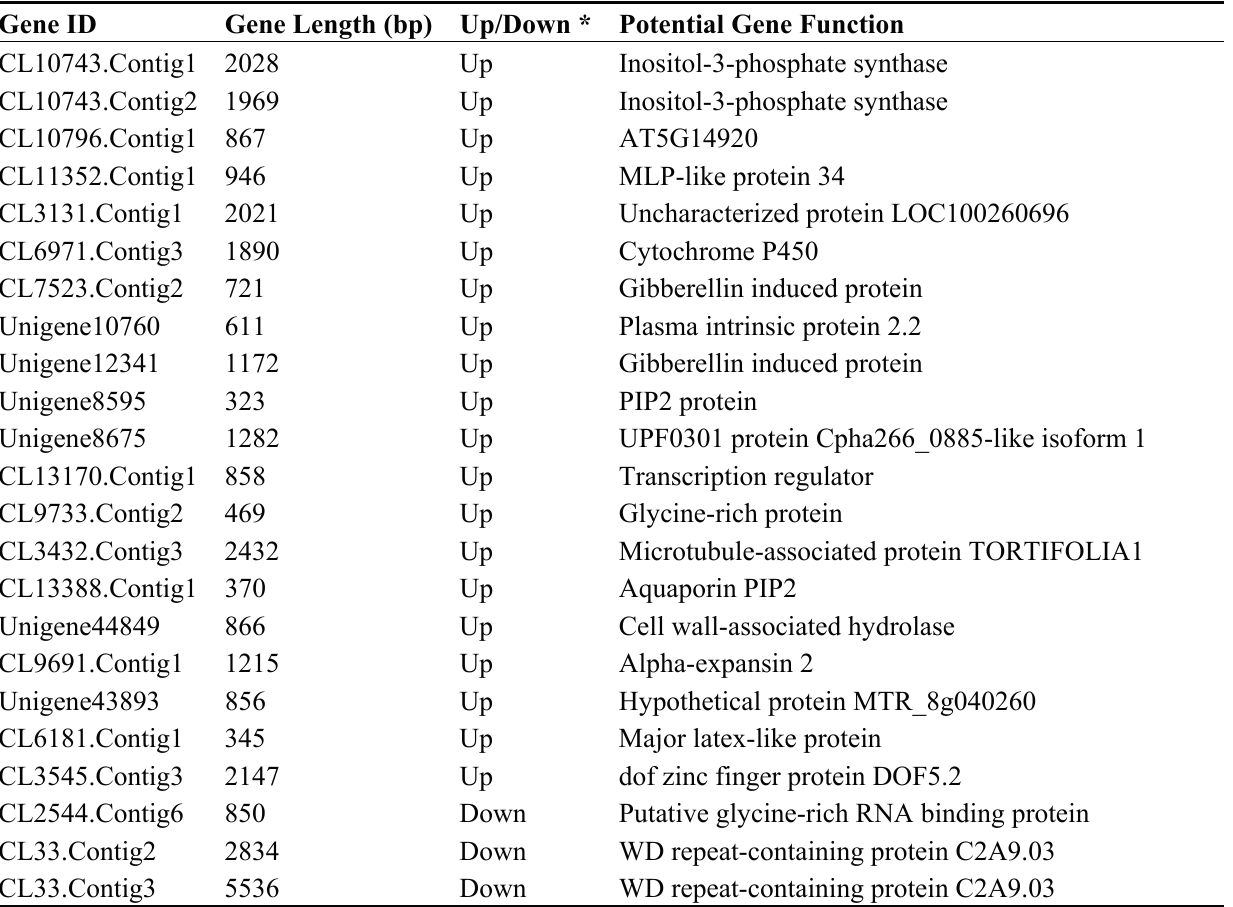
Table 3. Top up- and down-regulated differetially expressed genes (DEGs) and DEGs related to P. fortunei PaWB disease. DEGs up-regulated in the PFI vs. PF comparison and meanwhile down-regulated in the PFI-60 vs. PFI comparison were retrieved. So were the DEGs down-regulated in the PFI vs. PF comparison and meanwhile up-regulated in the PFI-60 vs. PFI comparison. PF represents the healthy wild-type sample of P. fortunei , PFI represents the sample of phytoplasma infected PF. PFI-60 represents the sample of 60 mg·L − 1 MMS treated